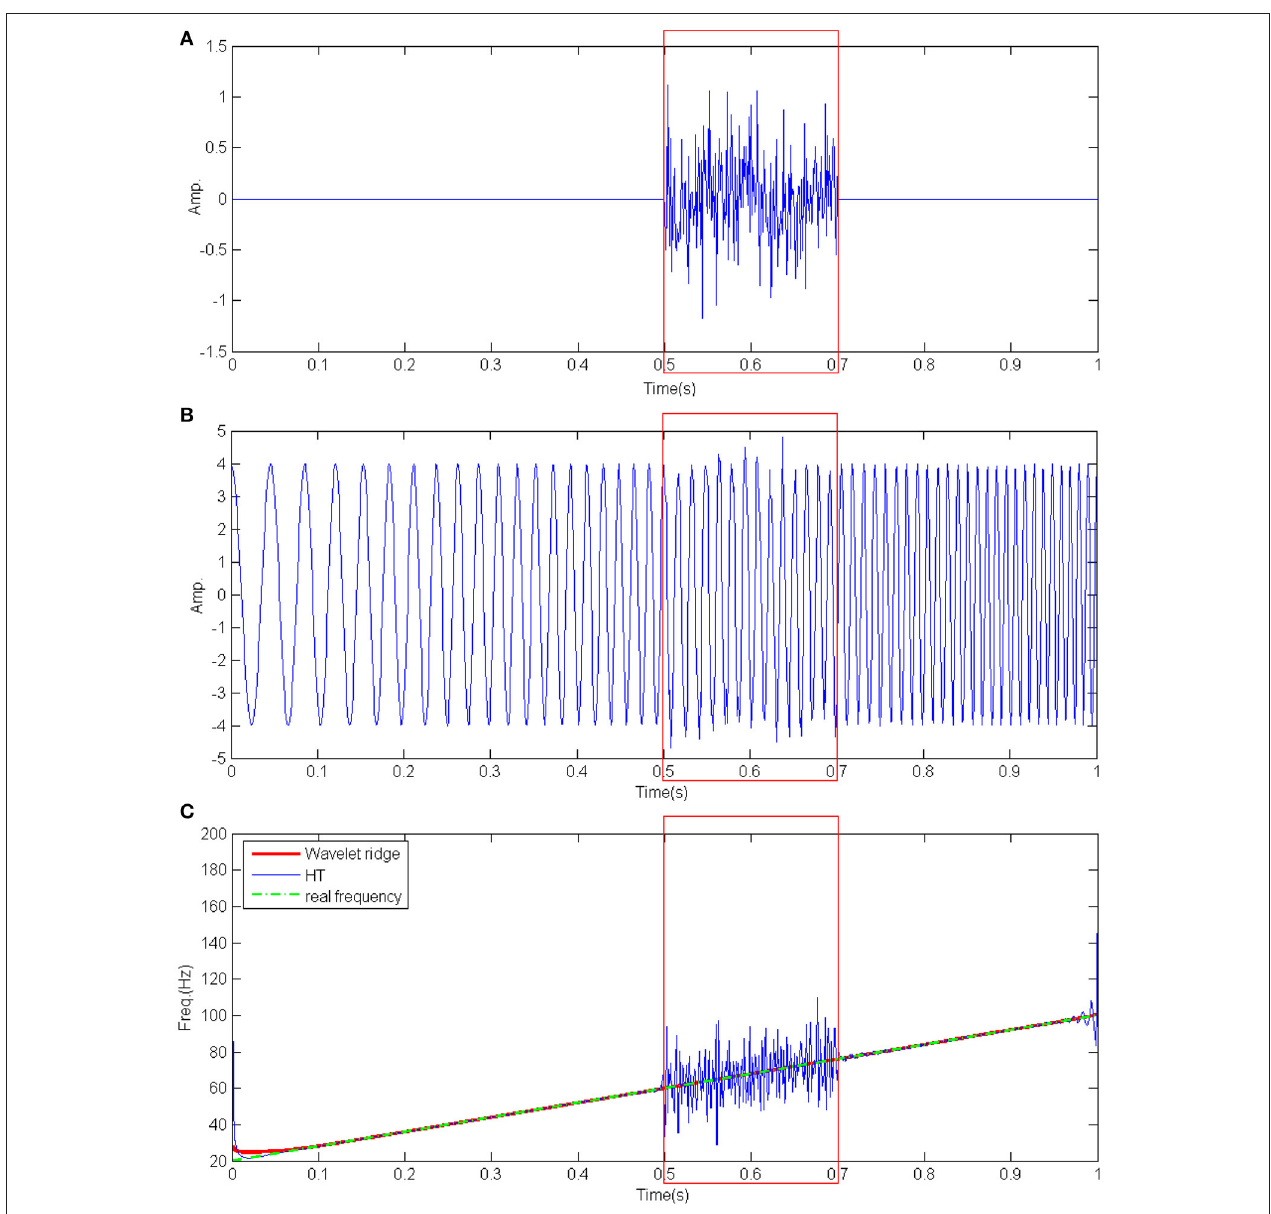
FIGURE 2 | EMD applied to the simulated signal with noise. (A) The added white noise with the mean of 0 and the variance of 0.2 within the time ranges from 0.5 to 0.7s. (B) The simulated signal with noise. (C) IF extracted respectively by wavelet ridge and HT. The real frequency of the simulated signal is plotted in green